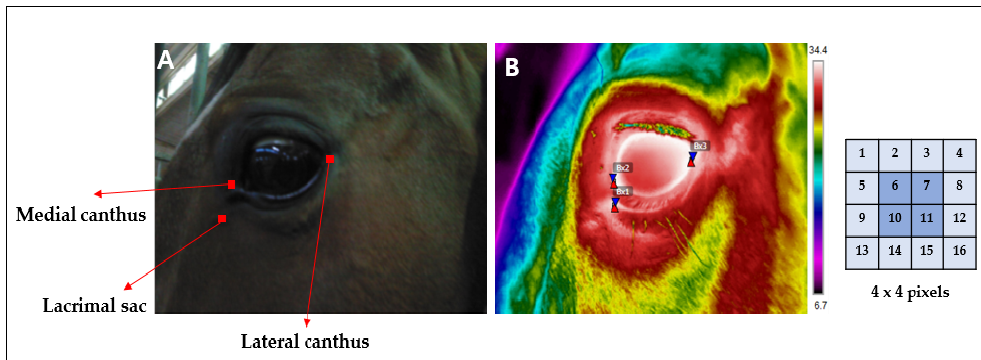
Figure 1. Three regions of interest (ROIs) of the eye for temperature measurement in horses. The size of each ROI was 4 × 4 pixels, in which the max and mean temperature are measured, and 2 × 2 pixels mean the center of the 4 × 4 pixels. ( A ): Image of a horse’s left eye; ( B ): Image of a horse’s left eye by IRT; Bx 1: Lacrimal sac; Bx 2: Medial canthus; Bx 3: Lateral canthus.